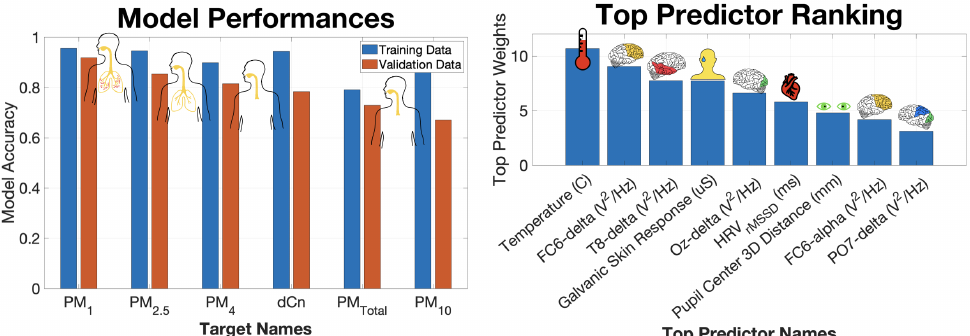
Figure 6. Summary of empirical PM concentration models estimated from 9 EEG and non-EEG biometric predictor variables. ( Left ) Ranking of model performance defined as squared correlation coefficient between predicted and true PM values. Training and validation dataset performances for each model are shown in blue and orange, respectively. Sorting is based on validation dataset perfor- mance. Overlaid graphics indicate the deposition of the respective PM size bins in the airways [25]. ( Right ) Predictor importance ranking aggregated across all 6